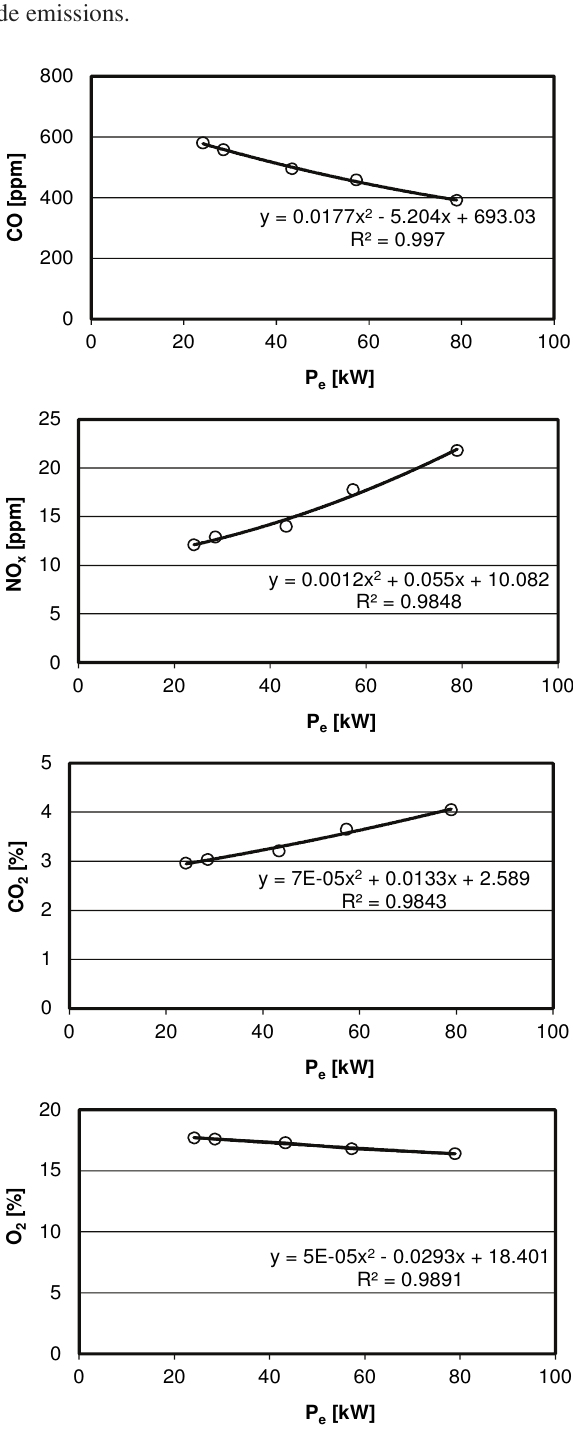
Fig. 7. Examples of the concentration of selected components of the exhaust gas as a function of the power of GTD-350 gas turbine engine Taking into account available parameters monitored in the engine room, the following one can be used: - rotor speed of gas generator, - the rotational speed of the separate power